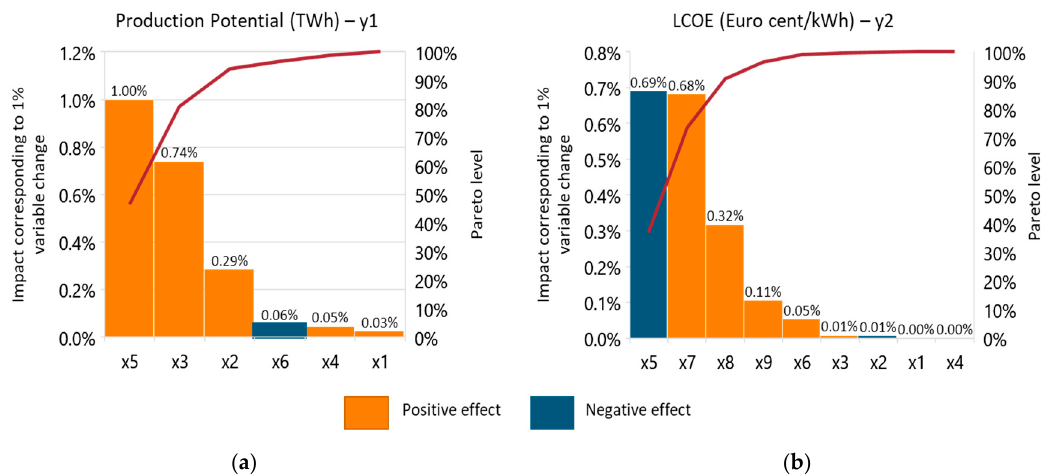
Figure 10. Comparing the influence of the considered parameters on the technical potential ( a ) and LCOE ( b ). Columns in orange, positive value; columns in blue, negative value; red lines, Pareto lines.